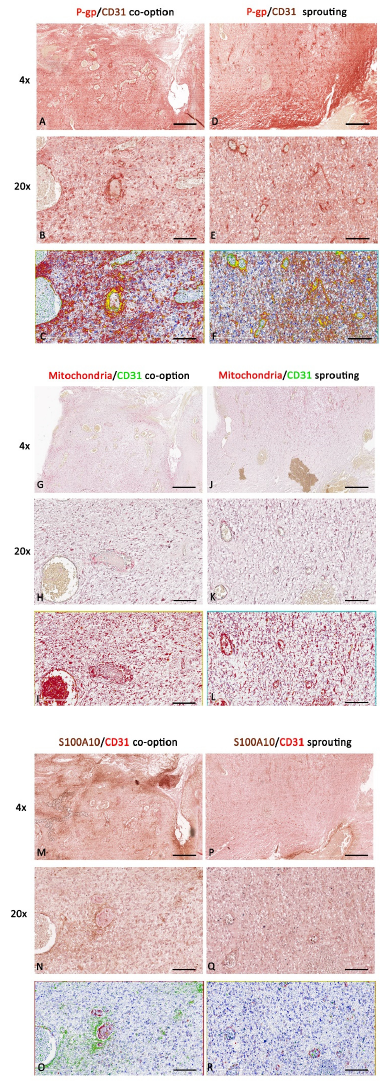
Figure 11. P-gp/CD31, mitochondria/CD31, and S100A10/CD31 expression and colocalization in IDH-WT glioblastoma. P-gp, mitochondria, S100A10, and CD31 were evaluated by immunohisto- chemistry within the same spatial ROIs on serial sections using the colocalization algorithm. P-gp, mitochondria, and S100A10 expression increase in the tumor area where vascular co-option prevails over sprouting angiogenesis ( A – C , G – I , M – O ). In the area where sprouting angiogenesis prevails, the CD31 expression ( D – F , J – L , P – R ) and the P-gp + CD31 co-expression ( D – F ) are increased compared with the area with a prevalence of vascular co-option ( A – C ). Scale bar: 4 × , 300 µ m; 20 × , 100 µ m. Be- low each micrograph is the relative markup image generated by the Aperio colocalization